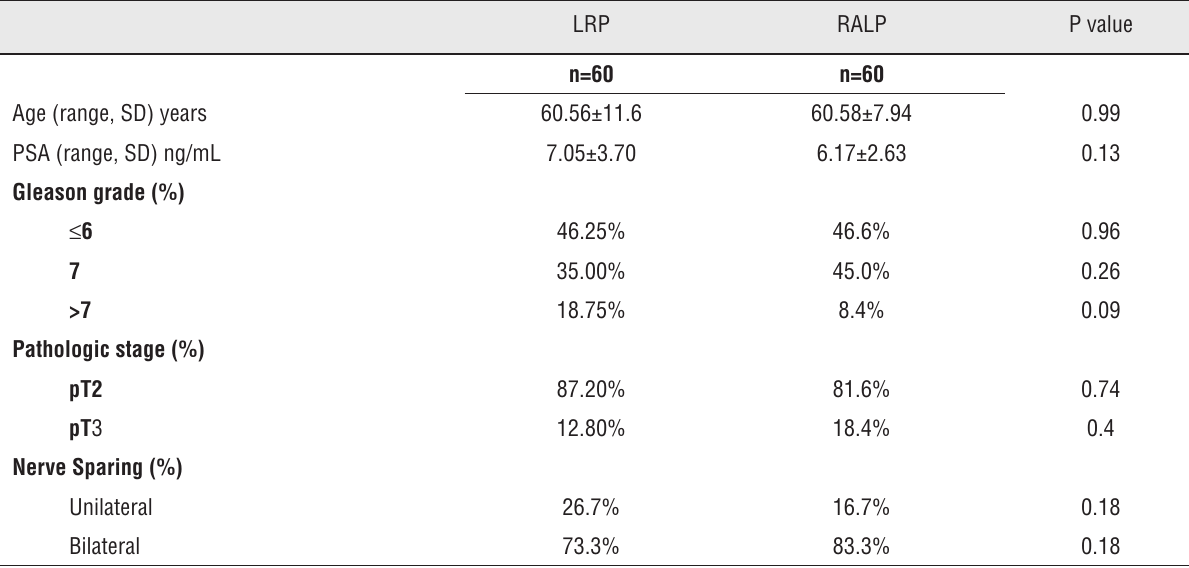
Table 1 - Preoperative patient characteristics. The groups were similar in terms of age, Psa level, gleason grade, nerve sparing and pathologic stage (T2,